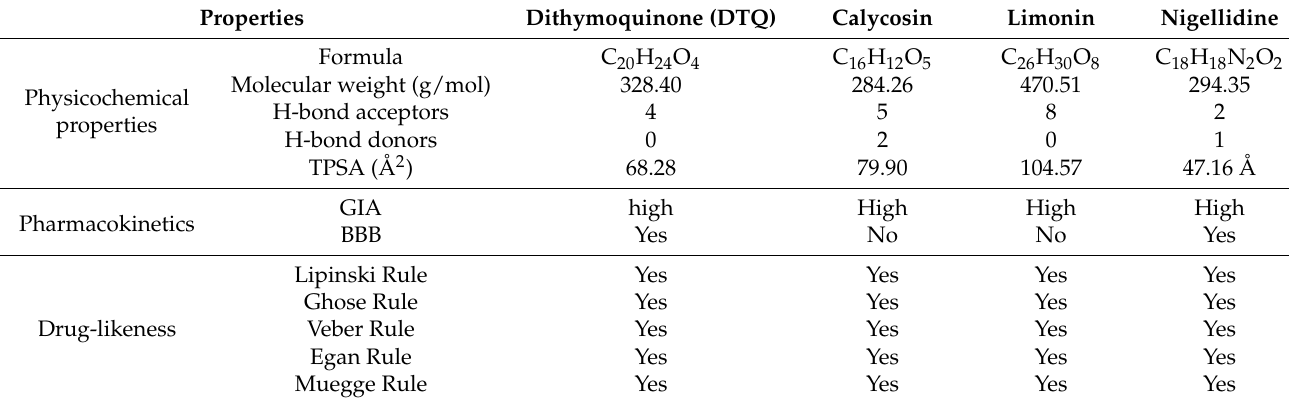
Table 1. Physicochemical properties of selected